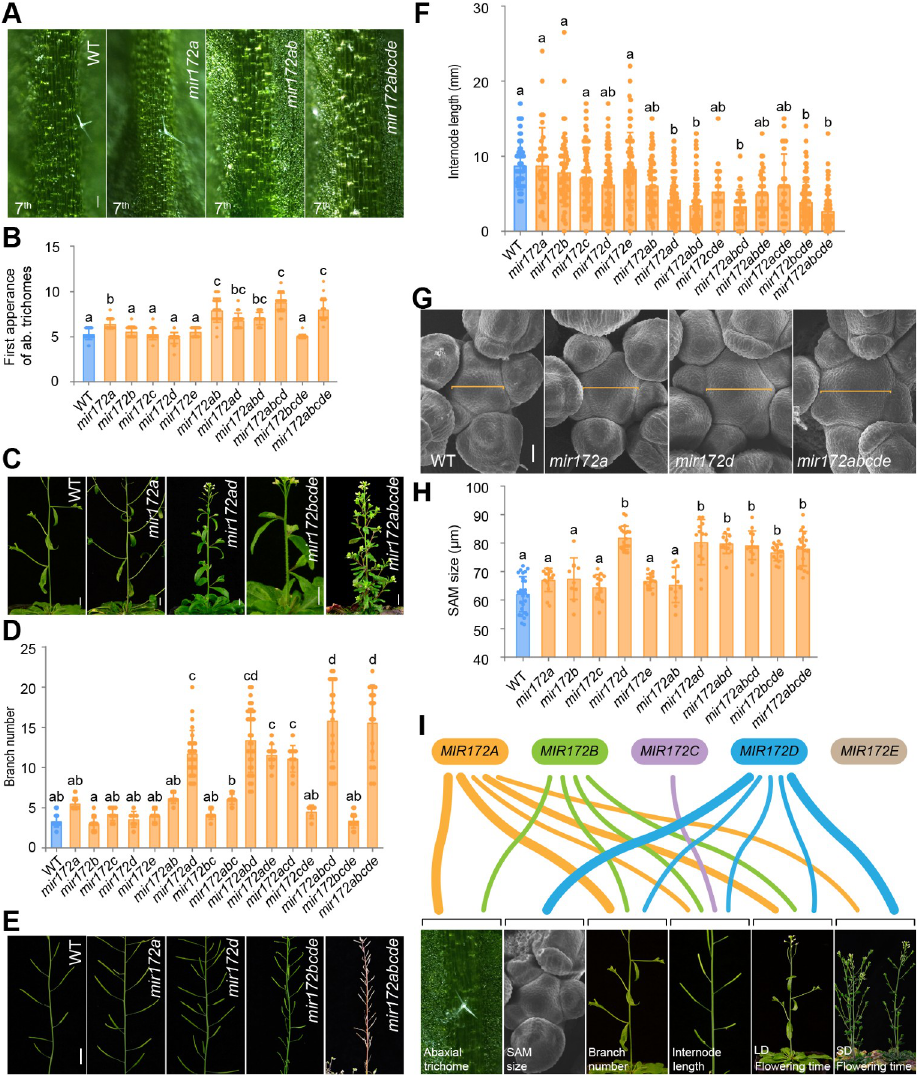
Fig 2. Phenotypic analyses of mir172 mutants. (A) Abaxial trichomes phenotype. The abaxial surface of the 7th leaf was shown. Scale bars represent 200 μ m. (B) Quantification of the abaxial trichomes in different genotypes. The 1st leaf with abaxial trichomes was scored. Error bars represent SEM ( n = 18–28). (C) Shoot branch phenotype. Scale bars represent 1.0 cm. (D) Quantification of shoot branch numbers in different genotypes. Error bars represent SEM ( n = 6–37). The statistically significant differences are determined by ordinary one-way ANOVA ( p < 0.05). (E) Internode length phenotype. Scale bars represent 1.0 cm. (F) Quantification of internode length. Error bars represent SEM ( n = 27–153). The statistically significant differences are determined by ordinary one-way ANOVA ( p < 0.05). (G) Inflorescence SAM size. Orange line, diameter of inflorescence SAM. Scale bars represent 20 μ m. (H) Quantification of the size of inflorescence SAM. Error bars represent SEM ( n = 10–29). The statistically significant differences are determined by ordinary one-way ANOVA ( p < 0.05). (I) Sankey diagram showing the contribution of each MIR172 gene to diverse developmental processes. The individual MIR172 gene was shown in different color. Line thickness stands for the contribution of each gene. The data underlying this figure are included in S1 Data. LD, long days; SAM, shoot apical meristem; SD, short days; WT, wild